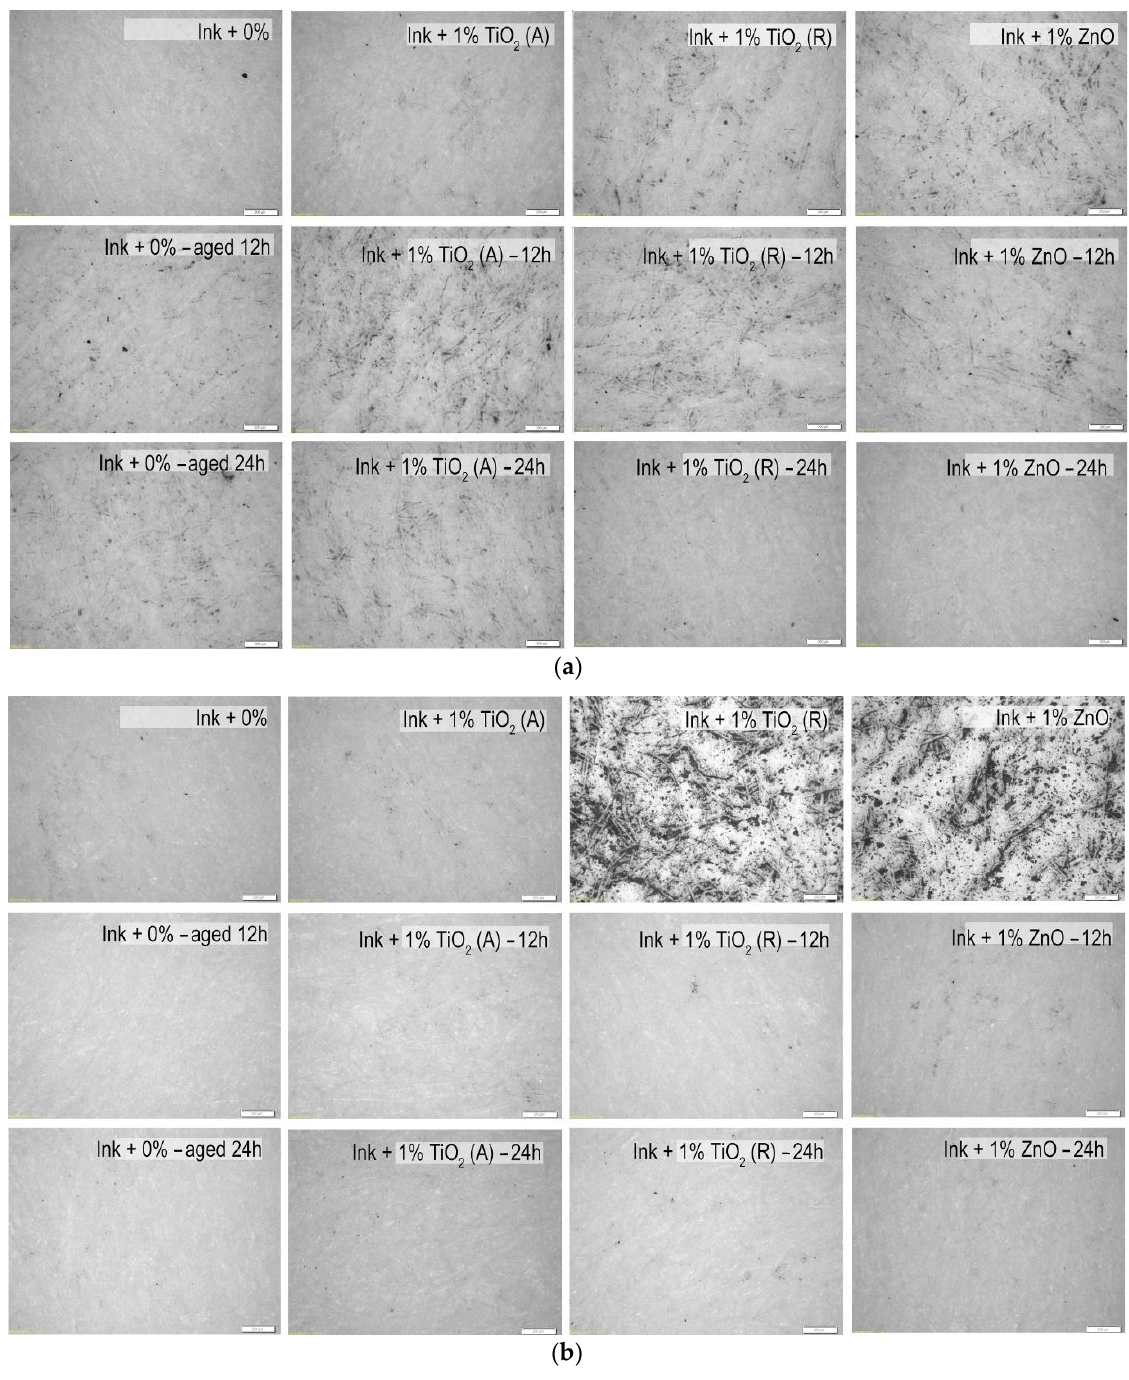
Figure 9. Microscopic images of the samples after performing the rub resistance test on unmodified and modified ink films on ( a ) uncoated and ( b ) coated paperboards (mag. 50×). It can be seen that all nanoparticles caused similar rub resistance. Rutile TiO 2 and ZnO nanoparticles showed significant improvement in rub resistance after 24 h of expo- sure on an uncoated paperboard substrate (Figure 9a). Furthermore, one can see that after 12 h of surface modification significant improvement in rub resistance was detected on coated paperboard (Figure 9b). Overall, those results are in correspondence with the ad- hesion properties of the same samples, because they have the highest values of thermo- dynamic work of adhesion ( W 12 ), indicating good adhesion between the modified materi- als (Figure 8). Resistance-to-bending results are presented in Figure 10. It can be seen that resistance to bending was improved in samples by the xenon radiation. 9 . 5 (b) Figure 10. The resistance to bending of unmodified and modified samples with TiO 2 (A), TiO 2 (R), and ZnO nanoparticles; ( a ) uncoated and ( b ) coated paperboard. Resistance-to-bending tests performed on samples showed a positive effect of surface modification on uncoated paperboard with the addition of all observed nanoparticles 0h 12h 24h4.24.44.64.85.07.0 7.58.0 8.5 9.09.5 R e s i s t an c e t o bend i ng ( m N ) Surface modification (h) Ink + 0% Ink + 1% Ti02 (A) Ink + 1% Ti02 (R) Ink + 1% ZnO 0h12h24h 4 . 2 4 . 4 4 . 6 4 . 8 5 . 0 7 . 0 7 . 5 8 . 0 8 . 5 9 . 0 R e s i s t an c e t o bend i ng ( m N )